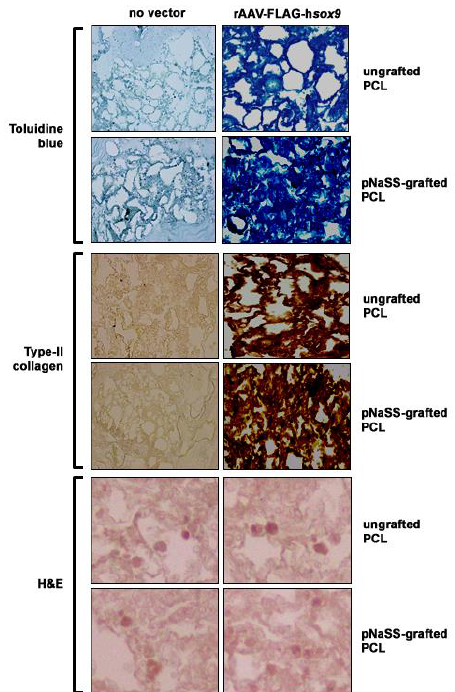
Figure 2. Induction of proteoglycan and type-II collagen deposition in human bone marrow aspirates transduced with rAAV sox9 -coated PCL films. pNaSS-grafted and ungrafted PCL films were coated with rAAV-FLAG-h sox9 or let without vector treatment prior to incubation with the aspirates and matrix proteoglycans (toluidine blue), type-II collagen immunoexpression, and cellularity (H&E) were evaluated after 21 days (magnification ×20 except for H&E at magnification ×40; all representative data).